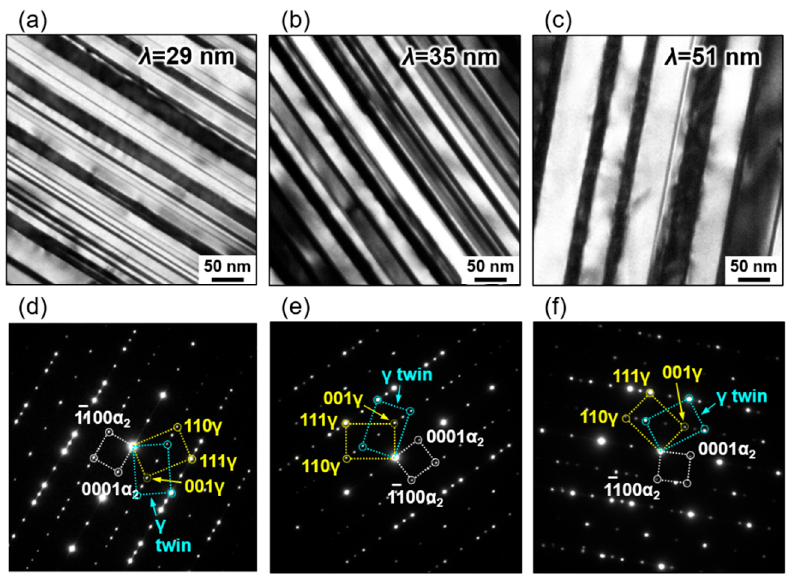
Figure 6. Typical BF images ( a – c ) and SAED patterns ( d – f ) of the lamellar grains in 0.1AG ( a ), ( d ), 0.5AG ( b ), ( e ) and 1AG ( c ), ( f ) with B = [11 (cid:3364) 0] γ //[112 (cid:3364) 0] α 2 .